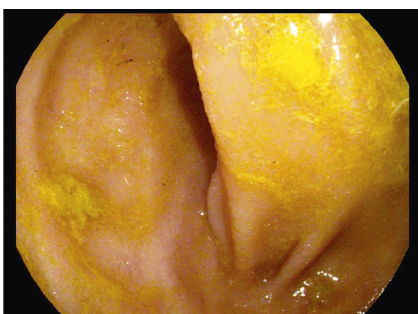
Figure 2: Colonoscopy showing ileal mucosal healing 6 months after starting vedolizumab and ustekinumab